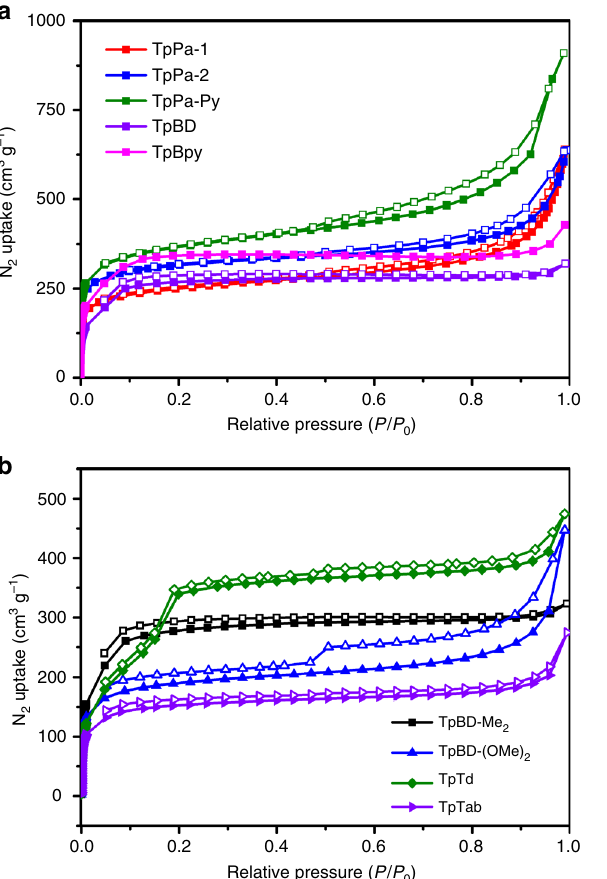
Fig. 6 N 2 adsorption and desorption isotherms of CCOFs. a TpPa-1, TpPa-2, TpPa-Py, TpBD, and TpBpy; b TpBD-Me 2 , TpBD-(OMe) 2 , TpTd, and